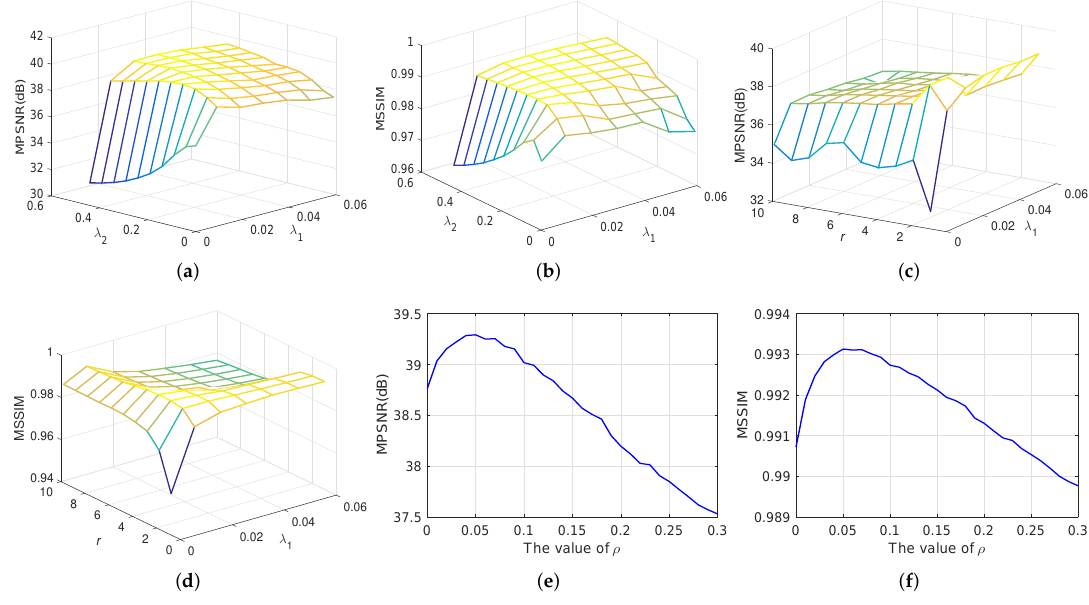
Figure 13. MPSNR and MSSIM as a function of the parameters (i.e., λ 1 , λ 2 , desired rank r and spectral proportion ρ ) in the proposed method for WDC dataset. ( a ) MPSNR VS λ 1 and λ 2 ; ( b ) MSSIM VS λ